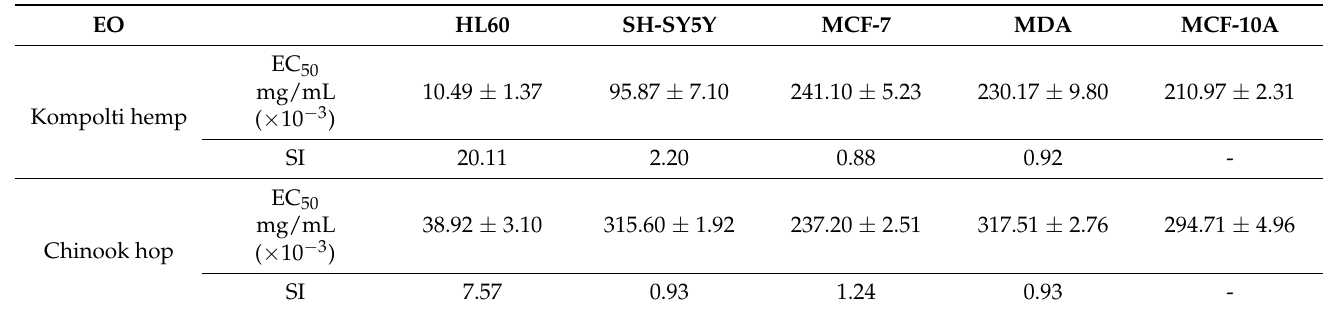
Table 3. EC 50 of Kompolti hemp and Chinook hop EOs obtained by dose-dependent MTT assay 48 h of treatments in human cancerous and non-cancerous cell lines. The values are expressed in mg/mL as mean ± standard error mean (sem). SI: Selectivity Index.